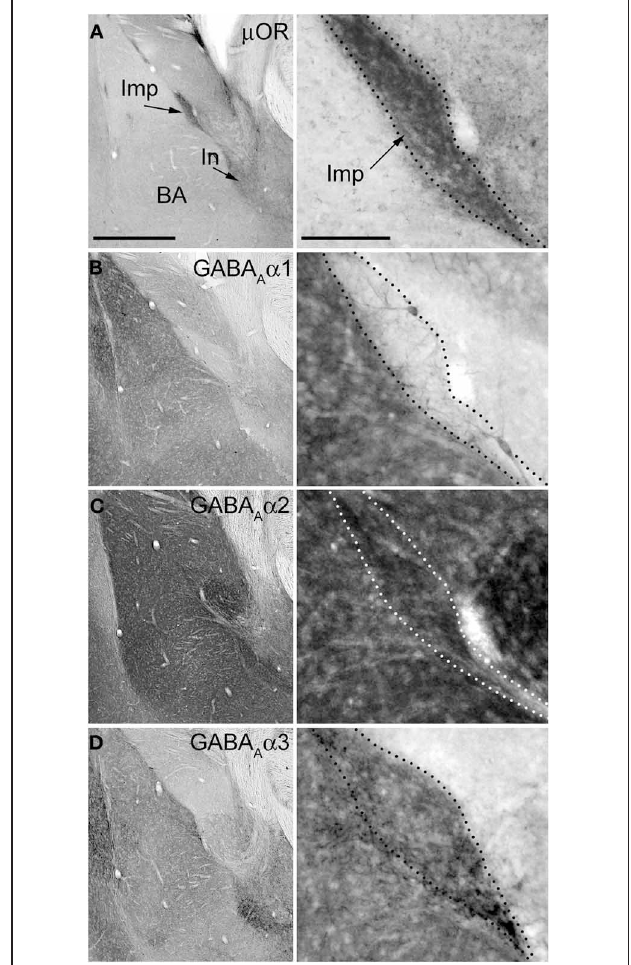
FIGURE 3 | Immunostainings for μ -opioid receptor and GABA A receptor subunits α 1–3 in consecutive sections of the mouse amygdala. Panels on the left show low magnification images of the basolateral (BL) complex and intercalated cell masses, whereas the panels on the right show a higher magnification of the Imp cluster. (A) Immunoreactivity for μ OR is particularly enriched in the intercalated cell masses such as the Imp and In (as indicated by the arrows). (B) Immunoreactivity for the α 1 subunit is very intense in the BL complex whereas it is undetectable in the Imp, although a few dendrites can be observed coursing across it and probably belonging to the strongly labeled large neurons located at the edges of the cluster. (C) The expression of the α 2 subunit appears particularly strong in both the BL complex and intercalated cell masses, including the Imp. (D) Immunoreactivity for the α 3 subunit can be observed throughout the amygdala although the intercalated cell masses display a stronger signal compared to the BL complex and central nucleus. Abbreviations: BA, basal nucleus of the amygdala; Imp, medial paracapsular intercalated cluster; In, main intercalated nucleus; μ -opioid receptor, μ OR. Scale bars: left panel, 500 μ m; right panel, 100 μ